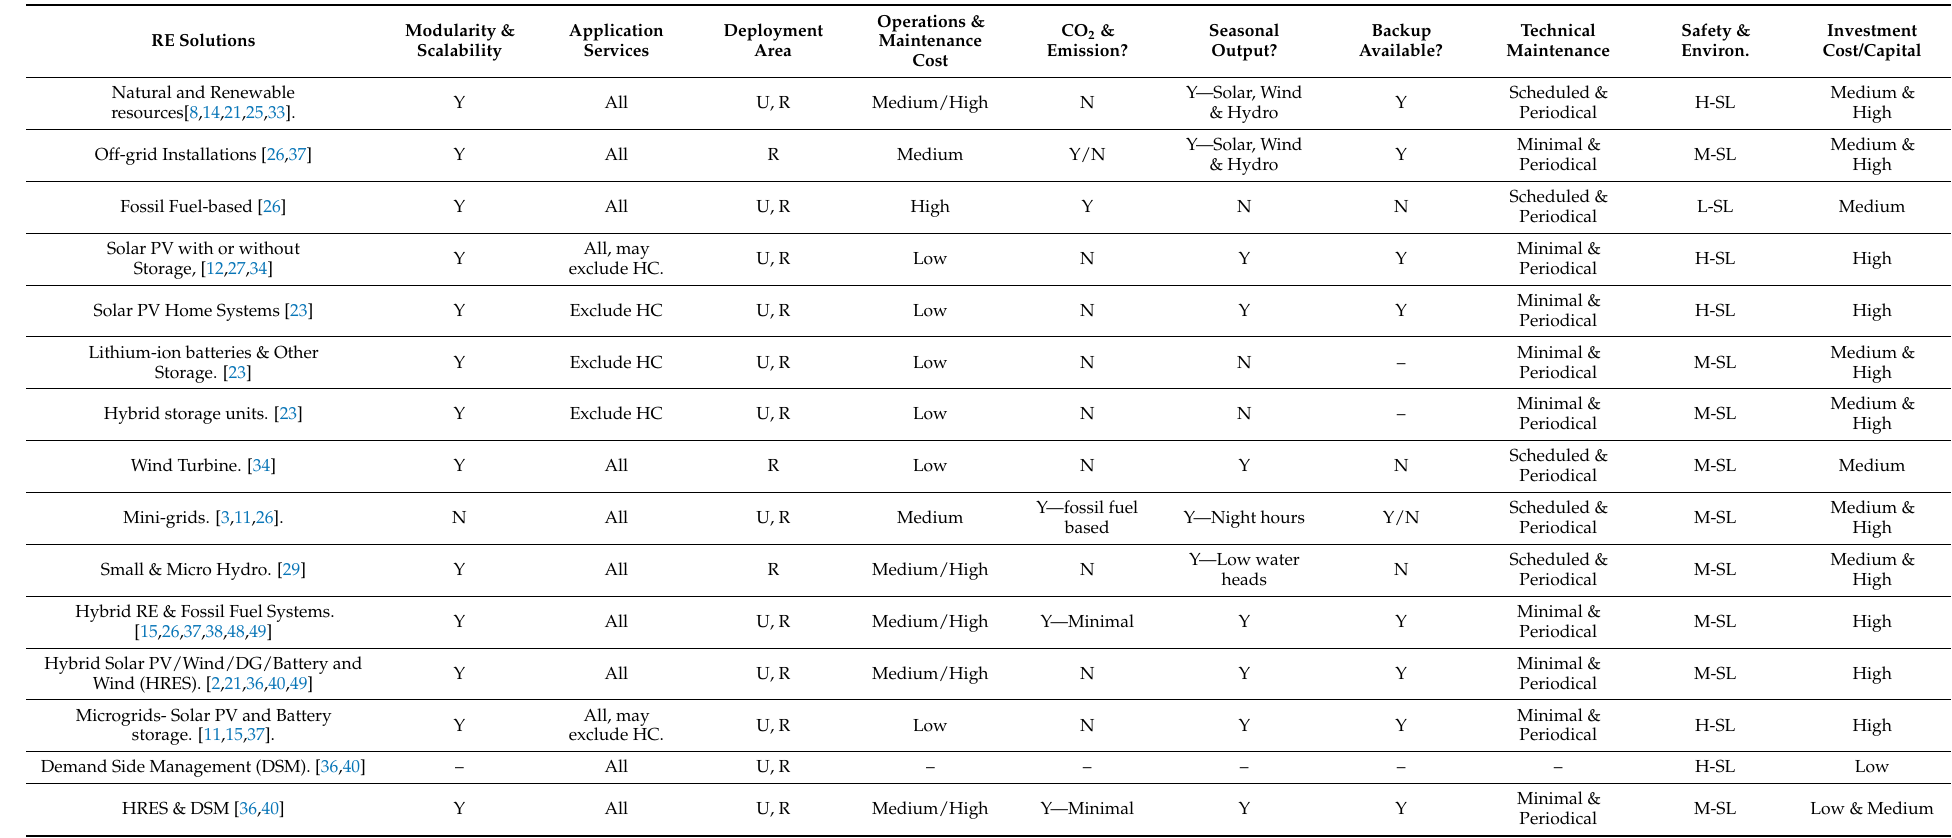
Table 2. Comparative overview of RE solutions in rural healthcare